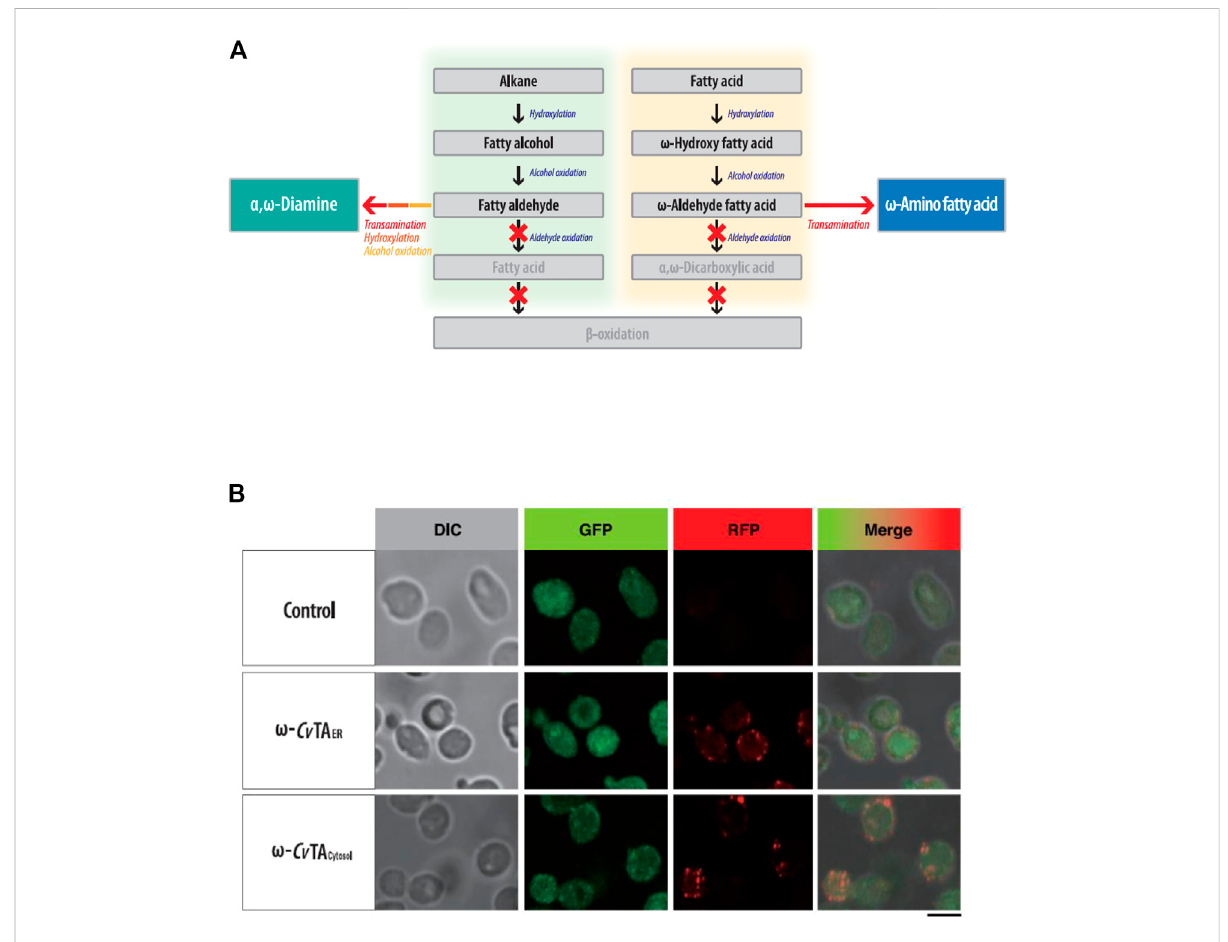
FIGURE 3 (A) Metabolic engineering of Y. lipolytica for the biotransformation of hydrocarbons (fatty alkane, alcohol, and acids) into the fatty polymeric monomers with amino residue. (B) Subcellular localization of ω - Cv TA ER and ω - Cv TA cytosol introduced into Y. lipolytica . Bar is 5 μ